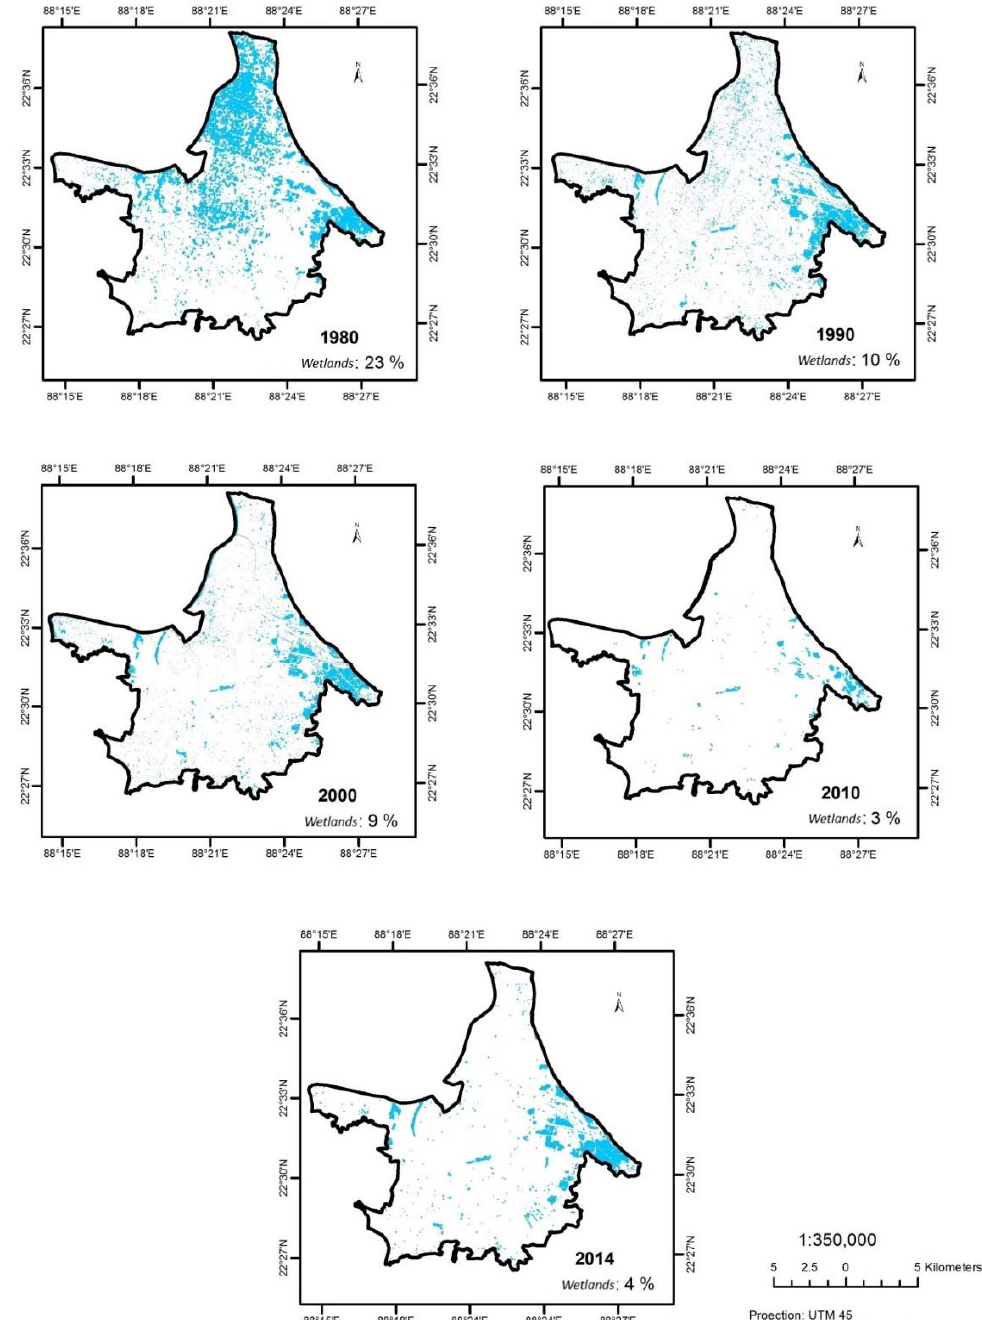
Figure 6. Distribution of wetlands (blue patches) within Kolkata Municipal Corporation area (KMC) area from 1980 to 2014 (decade-wise) (Data base courtesy: Satellite Image interpretation from Landsat (USGS) and LISS III series (ISRO, India) and the Govt. of West Bengal, India).